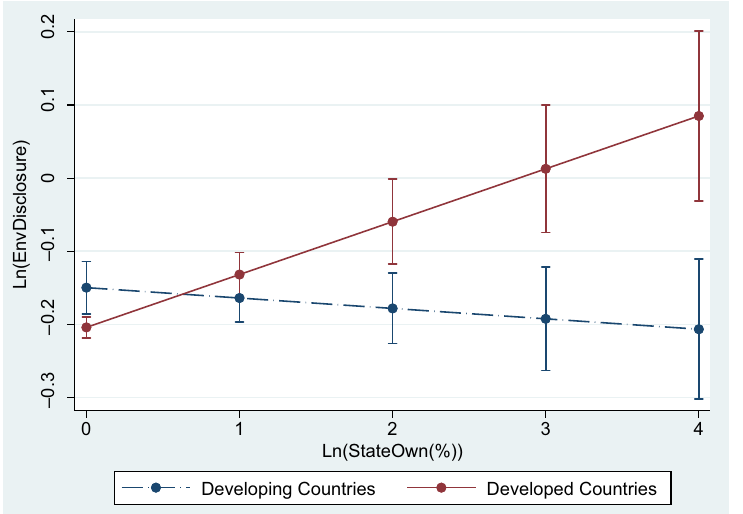
Figure 1. Interaction of Ln (StateOwn(%)) and developed